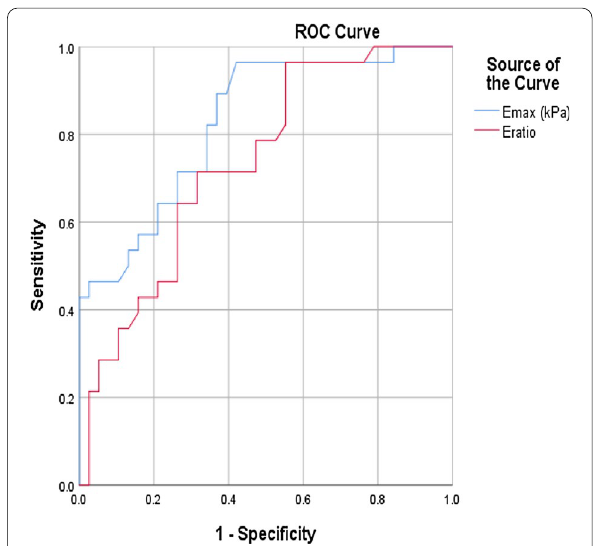
Fig. 1 ROC curve for calculating cut-off values of E max and E ratio using